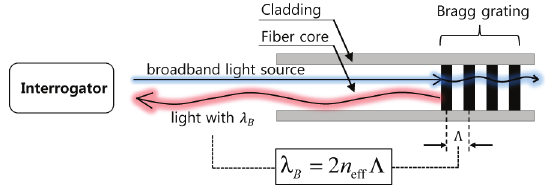
Fig. 1. Principle of fiber Bragg grating